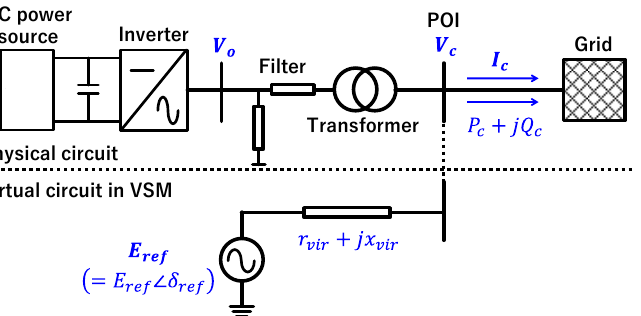
Figure 1. Physical configuration of inverter-based resource (IBR) interconnection and simulated vir- tual connection configuration in virtual synchronous machine (VSM), grid-forming virtual inertia control (VI-GFM).